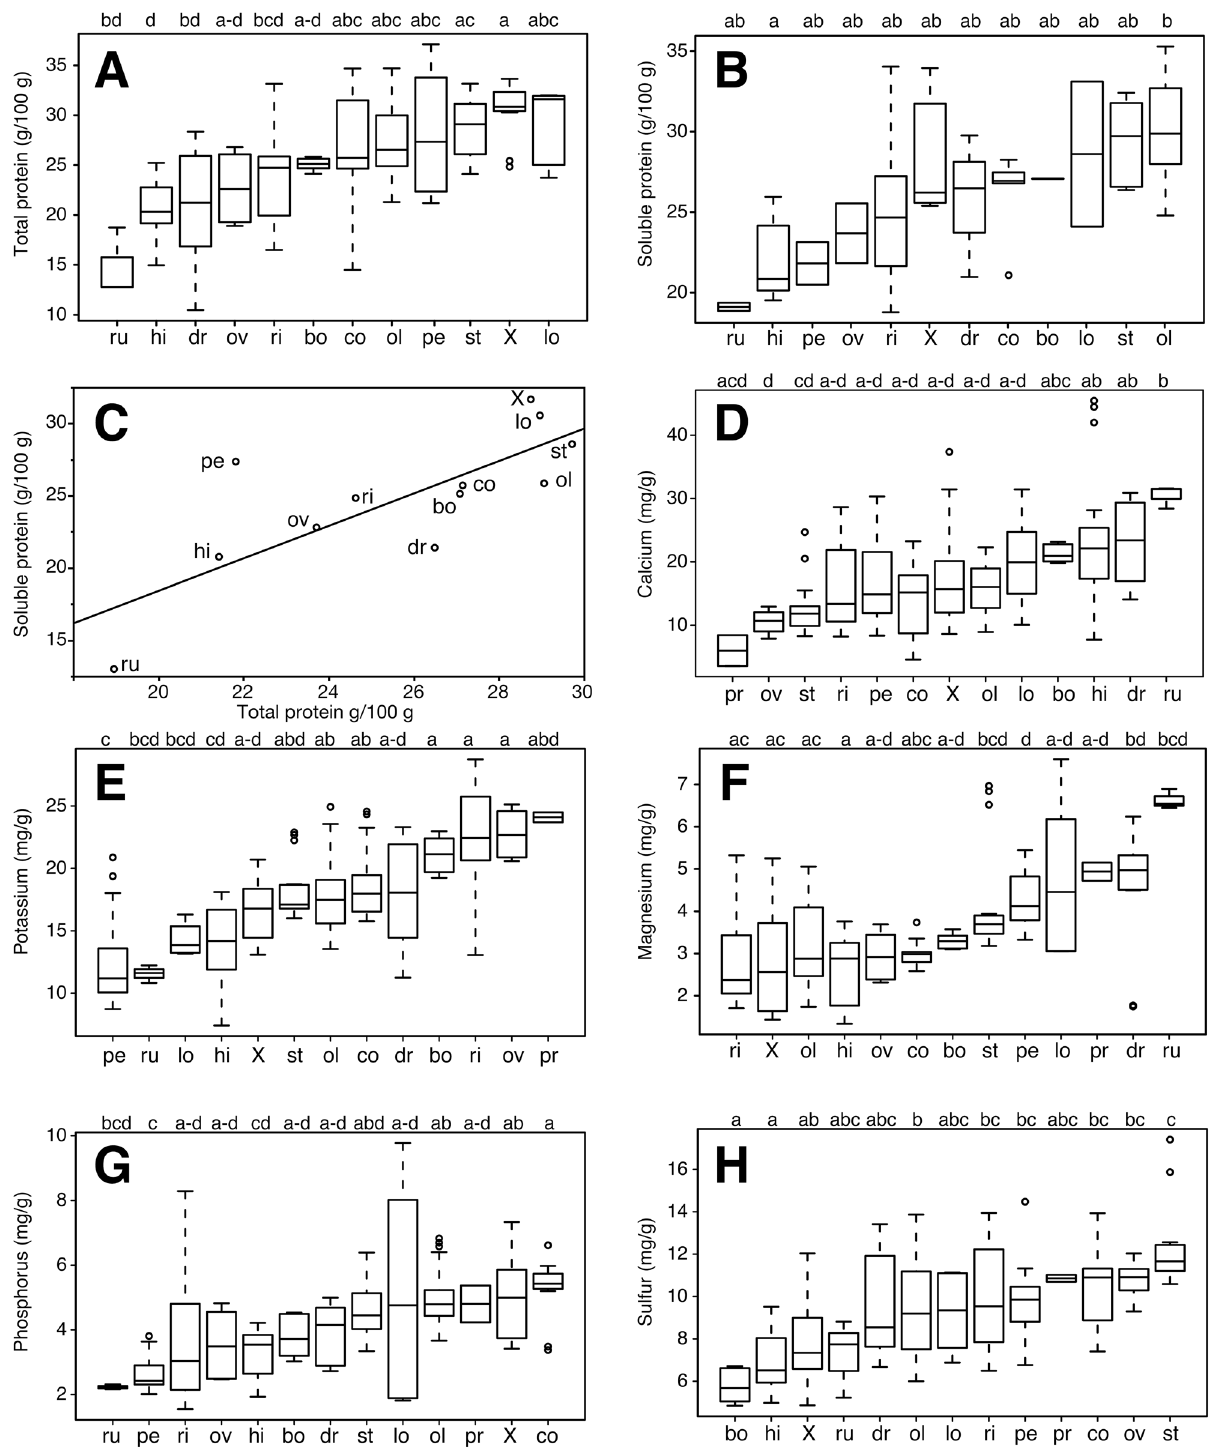
Fig 1. Boxplots and homogeneous groups for protein and macronutrients across Moringa species. (A) Total protein, (B) soluble protein, (C) The relationship between soluble and total protein has a slope of (cid:1) 1, showing that though there is some variation between methods, this variation seems random and they reflect essentially the same quantities. (D) Ca, (E) K, (F) Mg, (G) P, (F) S. Boxplots are based on the median. Species abbreviations as follows: bo = M . borziana , co = M . concanensis , dr = M . drouhardii , hi = M . hildebrandtii , lo = M . longituba , ol = M . oleifera , ov = M . ovalifolia , pe = M . peregrina leaflets, pr = M . peregrina rachis, ri = M . rivae , ru = M . ruspoliana , st = M . stenopetala , X = M . concanensis X oleifera . Letters denote statistically homogeneous groups as indicated by non-parametric posthoc tests.